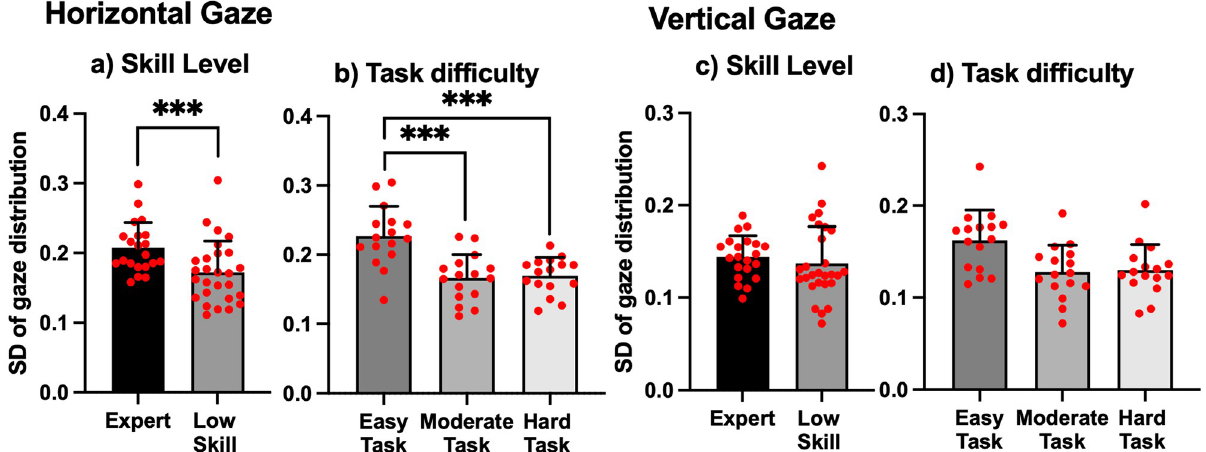
Fig 5. Gaze distributions. a, b: SD of gaze distribution in the horizontal direction. c, d: SD of gaze distribution in the vertical direction. Each red circle represents an individual data point. Significance level was set at ��� p < .001.